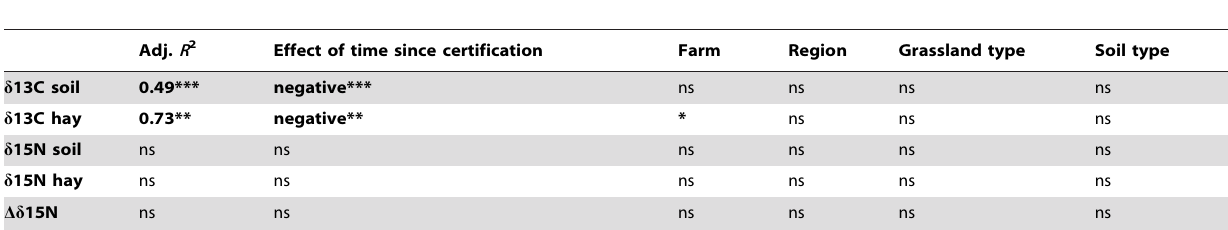
Table 2. Summary of ANCOVA models of isotopic abundances testing for relationships with the time since certification (only organic plots, n = 21).